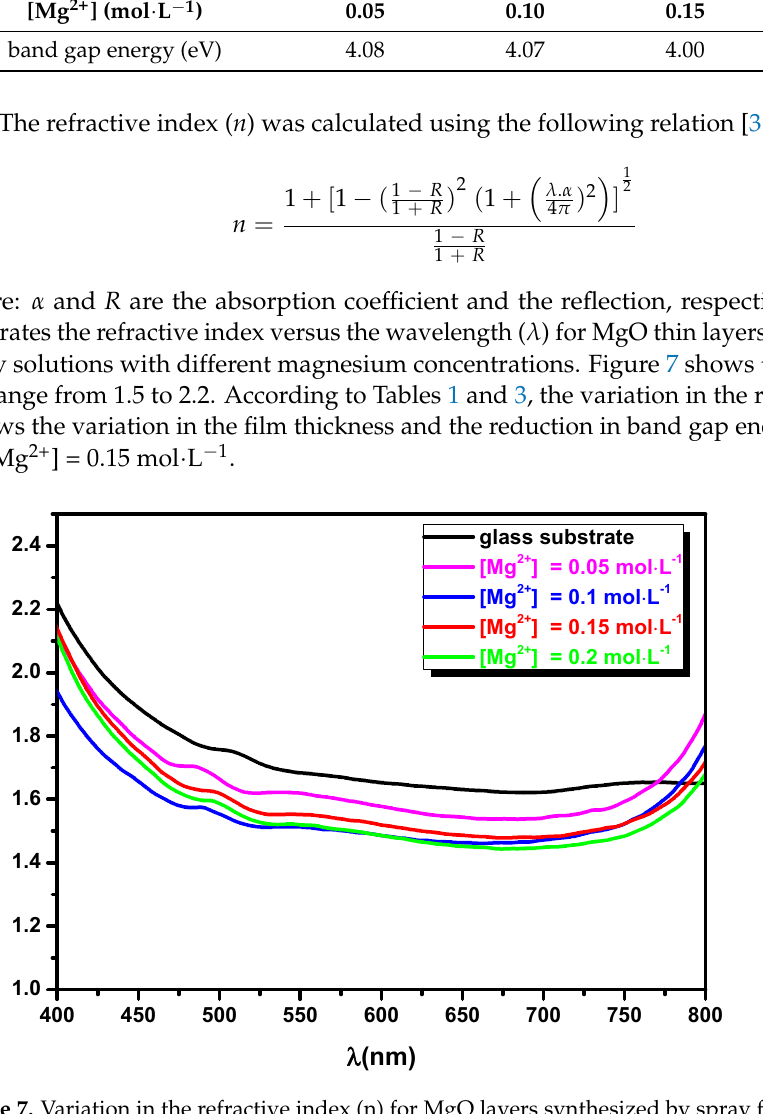
Table 2. Band gap energies of MgO elaborated for different concentrations [Mg 2+ ] = 0.05; 0.10; 0.15; and 0.20 mol · L − 1 .